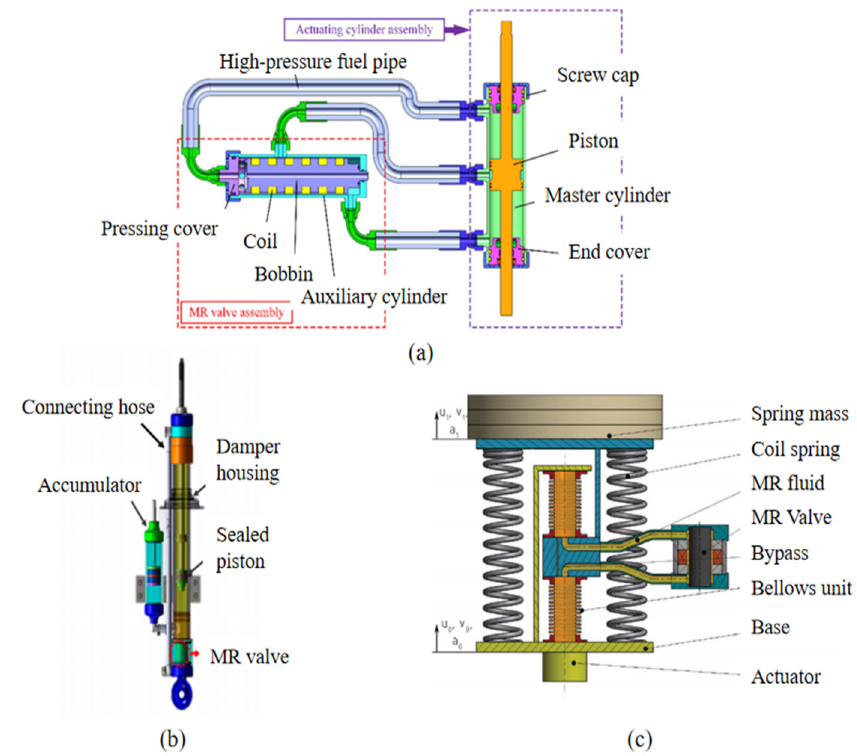
Figure 13. Bypass MRDs with overall layout optimization: ( a ) Multi-channel bypass MRD [80]. ( b ) Concentric serpentine fl ux valve MRD [82]. ( c ) Flexible metal bellows MRD [83].